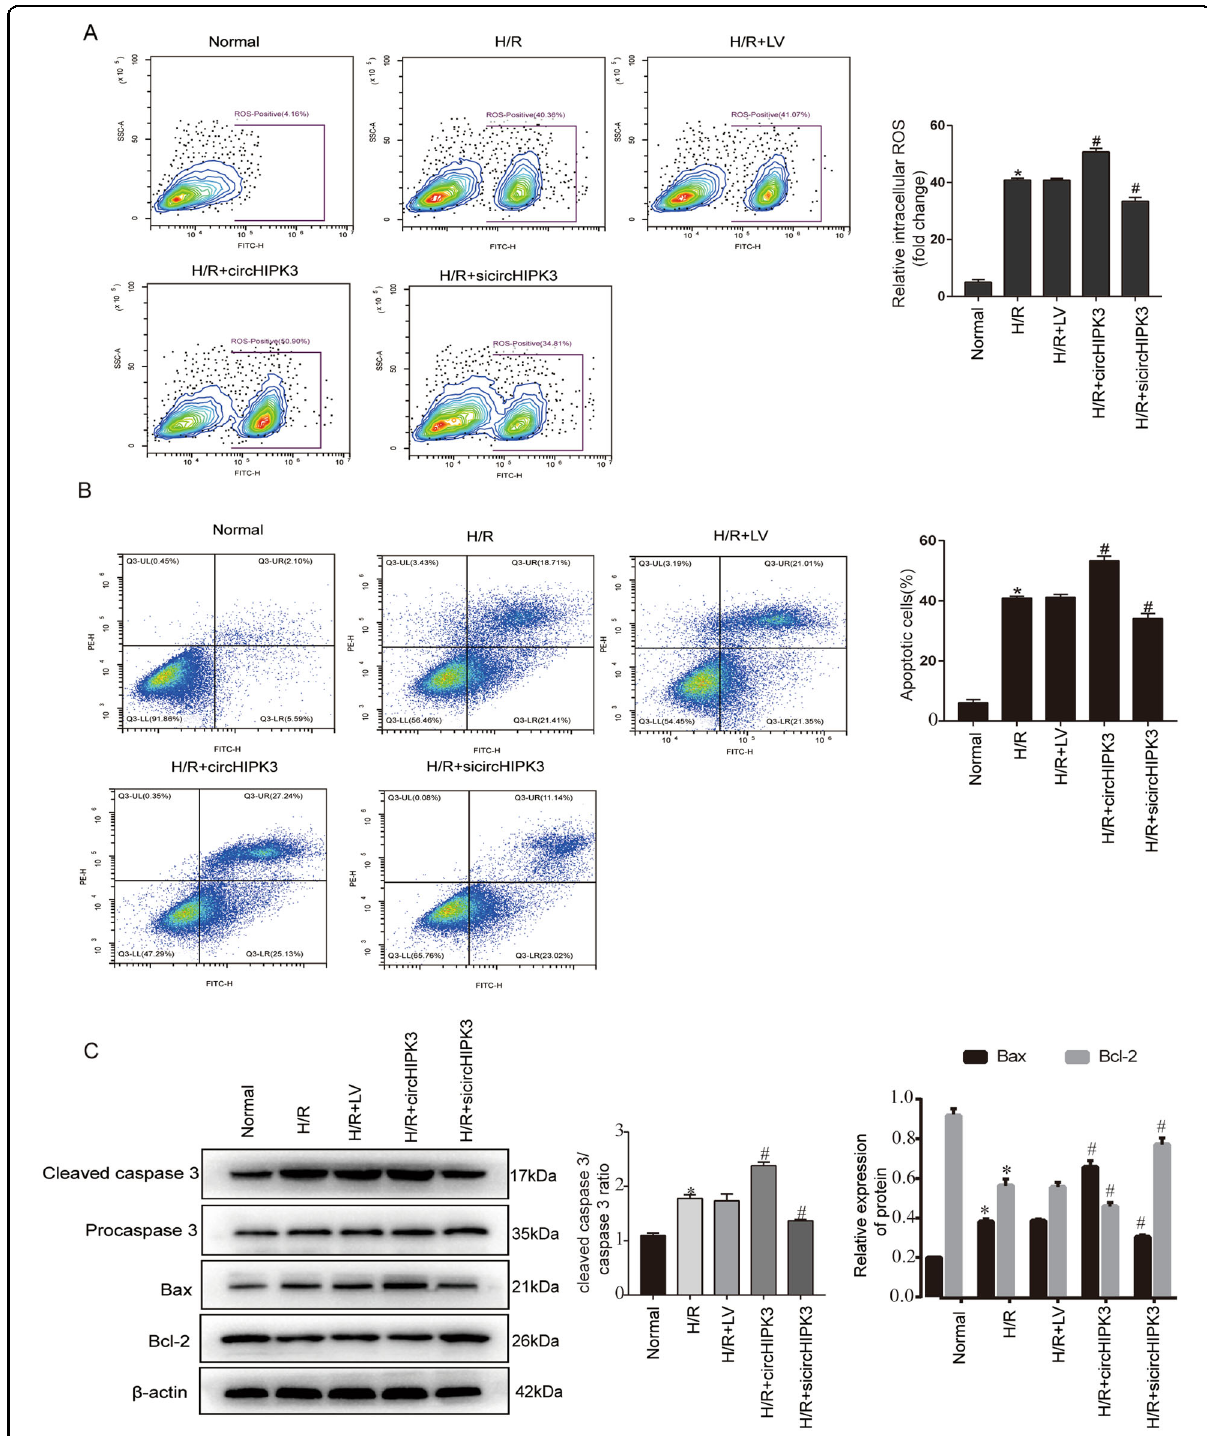
Fig. 2 CircHIPK3 promotes H/R-induced cardiomyocyte apoptosis. A The intracellular ROS level was detected by fl ow cytometry. n = 3. B Annexin V-FITC/PI fl ow cytometry was used to evaluate the effect of circHIPK3 on cardiomyocyte apoptosis. n = 3. C Apoptosis-related proteins, including procaspase-3, cleaved caspase-3, Bax, and Bcl-2, were detected by western blotting. n = 3. * P < 0.05 compared with the normal group. # P < 0.05 compared with the H/R